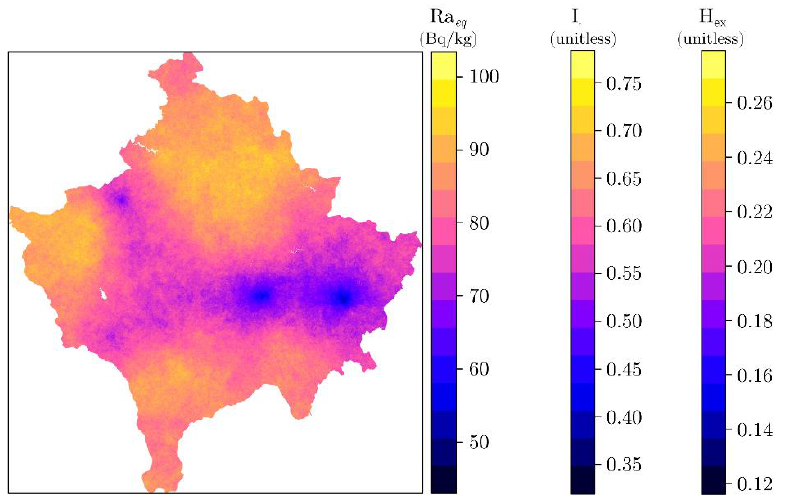
Figure 6. The values of radiological hazard parameters, based on measured and simulated data from the soil.